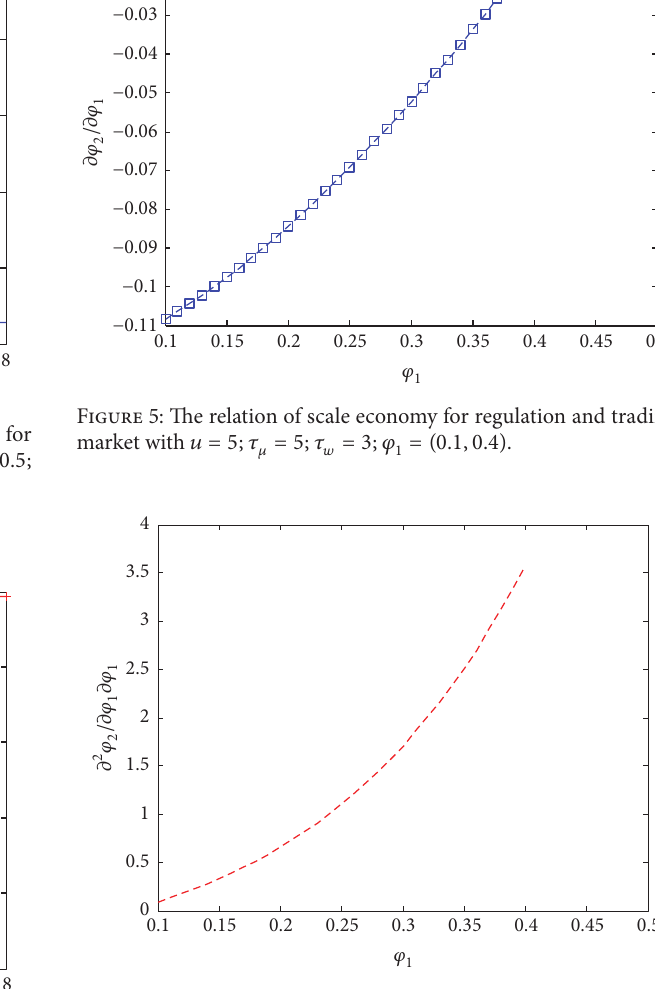
Figure 6: The change rate for the relation of scale economy for regulation and trading market with 𝑢 = 5 ; 𝜏 𝜇 = 5 ; 𝜏 𝑤 = 3 ; = (0.1, 0.4) 𝜑 1